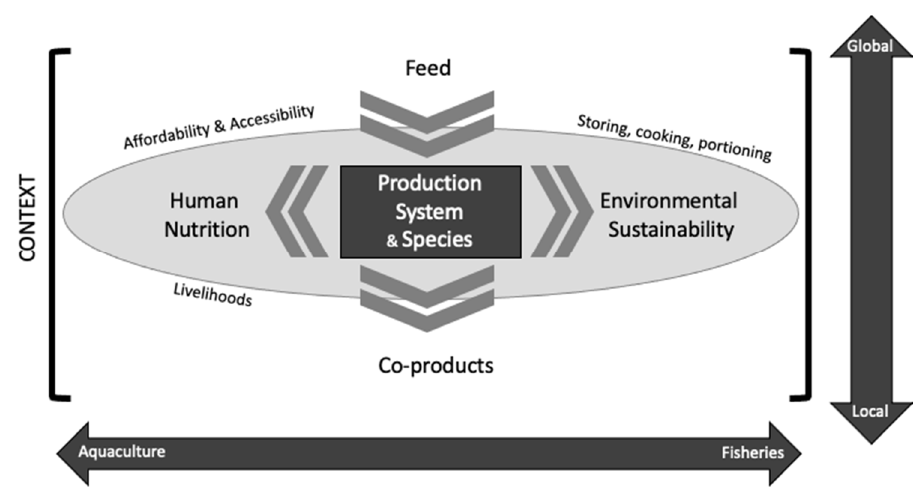
Figure 2. Framing of the role of aquatic animals in food systems, under current understandings of food systems theory, value chains, livelihoods, nutritional outcomes, and planetary boundaries thinking.